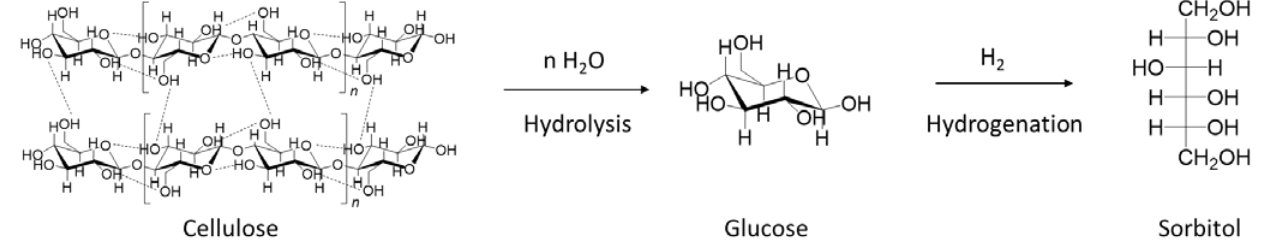
Figure 1. Depolymerization of cellulose by hydrolysis to glucose and further hydrogenation to